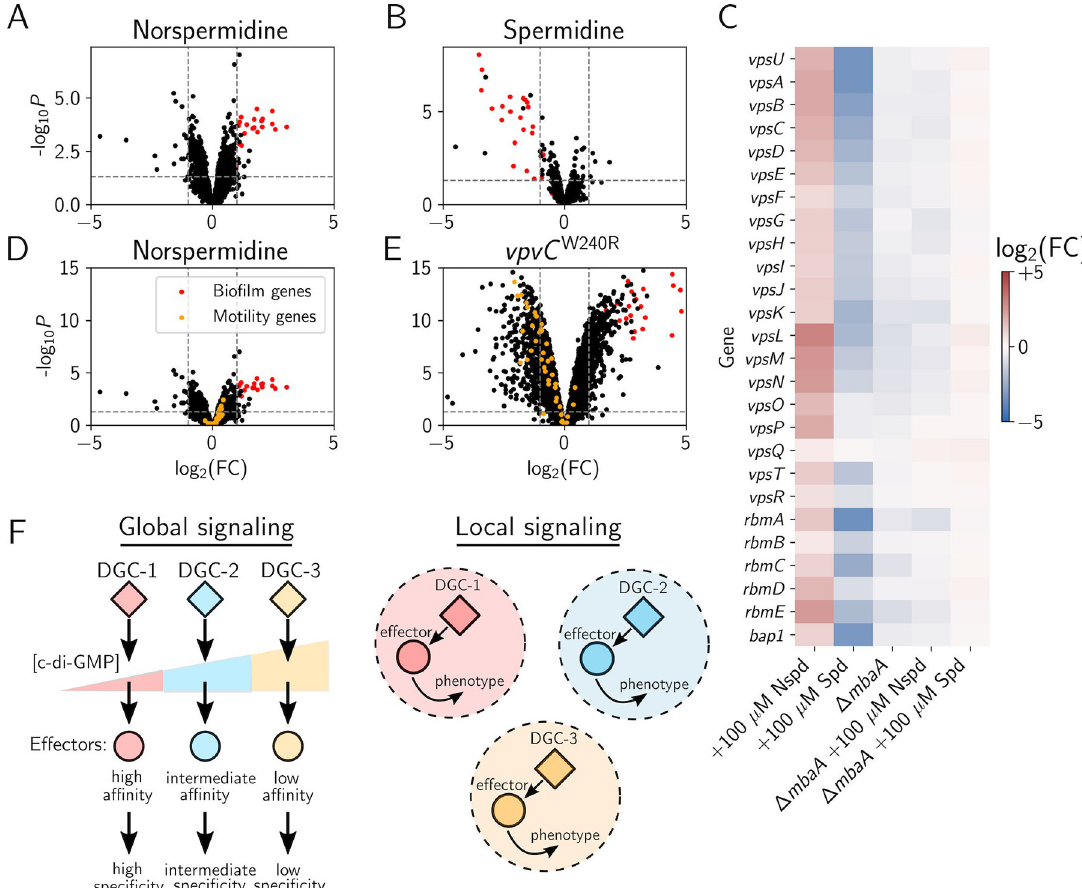
Fig 5. Polyamine signaling through the NspS-MbaA circuit specifically controls biofilm gene expression. (A) Volcano plot showing FCs in gene expression measured by RNA sequencing of the transcriptome of wild-type V . cholerae following administration of 100 μ M Nspd relative to that of the untreated control. vps genes are highlighted in red, the horizontal dotted line represents a p -value of 0.05, and left and right vertical dashed lines represent log 2 FCs of − 1 and 1, respectively. Samples were collected at OD 600 = 0.1 and N = 3 biological replicates. Complete datasets are available in S2–S11 Data. (B) As in A for 100 μ M Spd. (C) Heatmap showing FCs in V . cholerae biofilm gene expression for the indicated treatments and strains relative to untreated wild-type V . cholerae (lanes 1–3) or the untreated Δ mbaA strain (lanes 4–5). Red and blue represent increased and decreased gene expression levels, respectively. (D) Identical data as in panel A, rescaled for ease of comparison to the V . cholerae vpvC W240R strain. vps genes are highlighted in red, and motility genes are depicted in orange. (E) As in A, for the V . cholerae vpvC W240R strain, FCs are relative to the untreated wild-type strain. (F) Schematic comparing the proposed global (left panel) and local (right panel) models to achieve specificity in c-di-GMP signaling circuits. See text for details. (Reviewed in [12,14]). Numerical values for plots are available in S1 Data. c-di-GMP, cyclic diguanylate; DGC, diguanylate cyclase. FC, fold change; Nspd, norspermidine; Spd, spermidine; vps , vibrio polysaccharide biosynthesis genes.